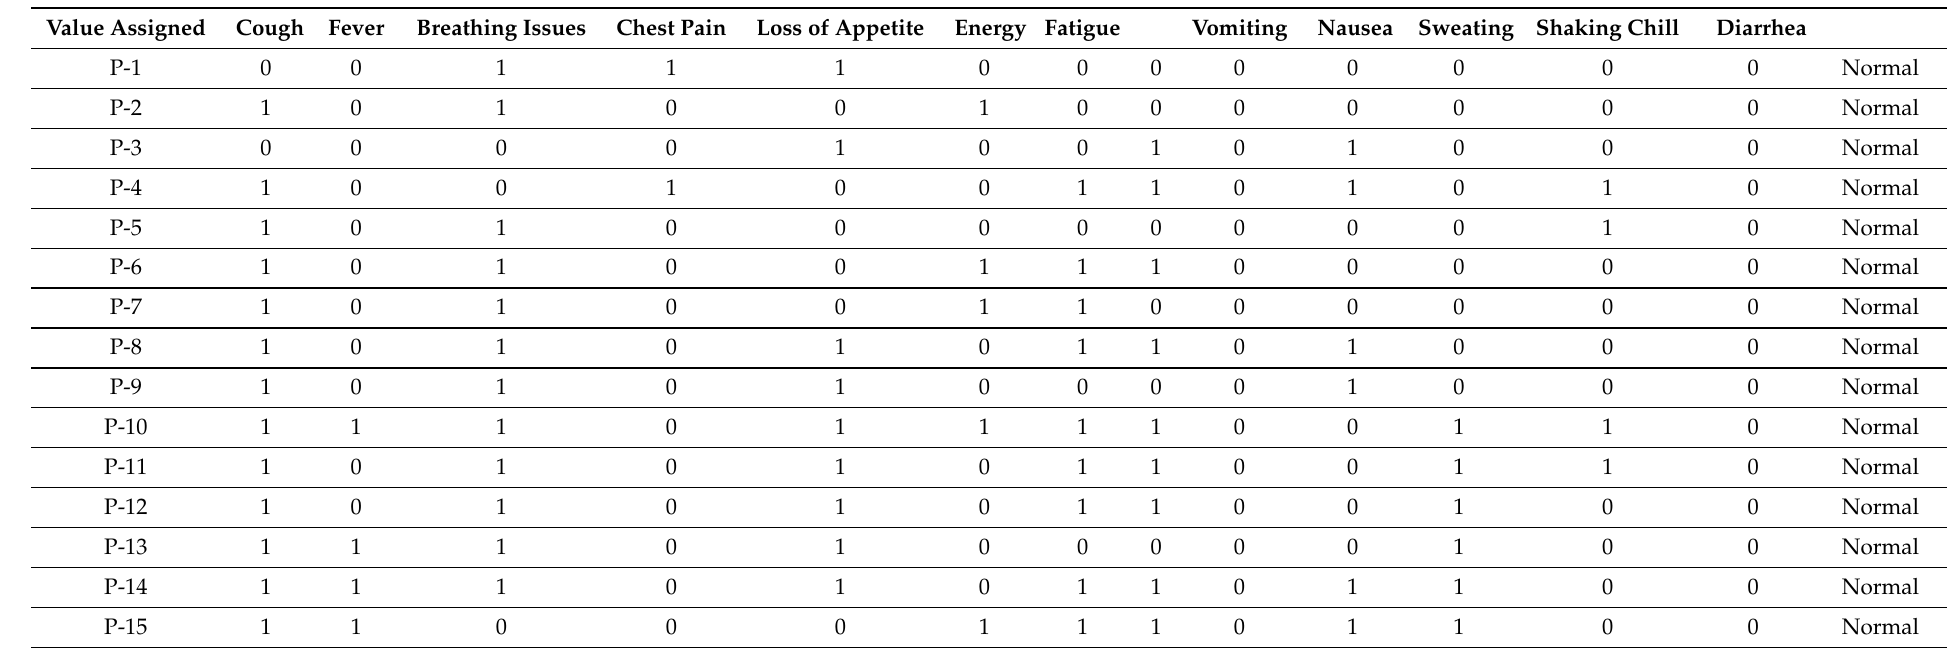
Table 3. Data for first 60